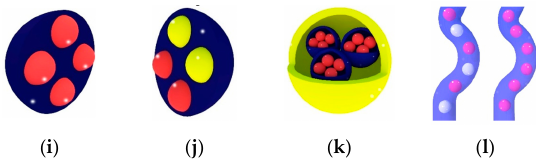
Figure 1. Different configurations and orders of multiple emulsion drops. ( a ) Double emulsion;